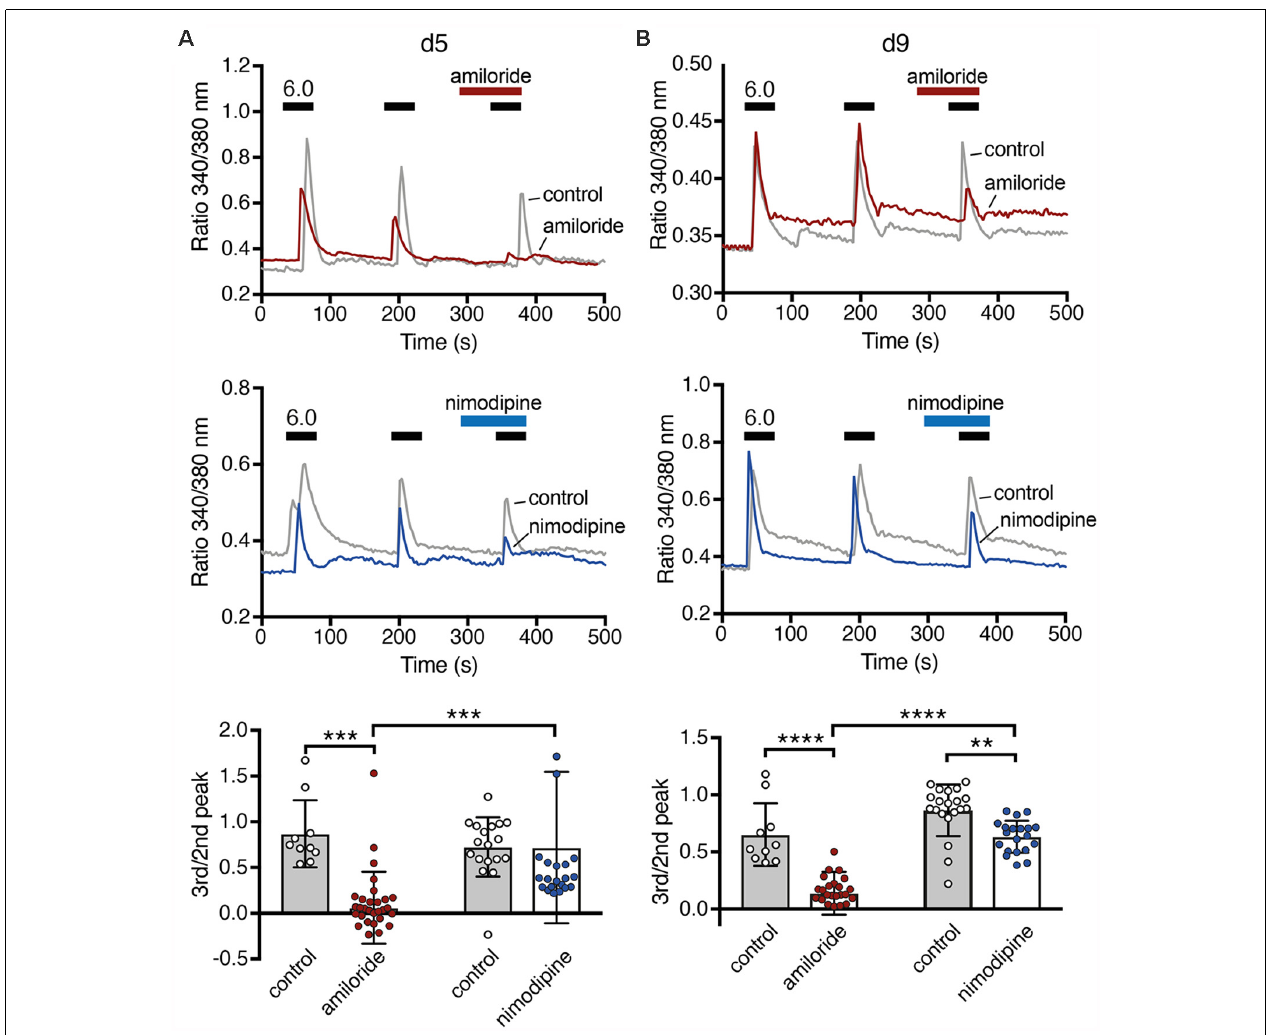
FIGURE 7 | Ca 2+ responses of LUHMES cells after acidic stimulation. (A) Top, representative recordings of intracellular Ca 2+ by Fura-2 in LUHMES cells at d5. Cells were repeatedly stimulated with pH 6 (black bars). For some cells, 100 µ M amiloride was pre- and co-applied during the third stimulation (red bar). The gray trace represents the mean response of > 10 control cells from one coverslip and the red trace of > 10 cells from another coverslip exposed to amiloride. Middle, as for the top panel but with 10 µ M nimodipine instead of amiloride. The blue trace is from cells exposed to nimodipine. Bottom, summary data. (B) As in (A) but for d9, ** p < 0.01, *** p < 0.001, **** p < 0.0001 (two-way